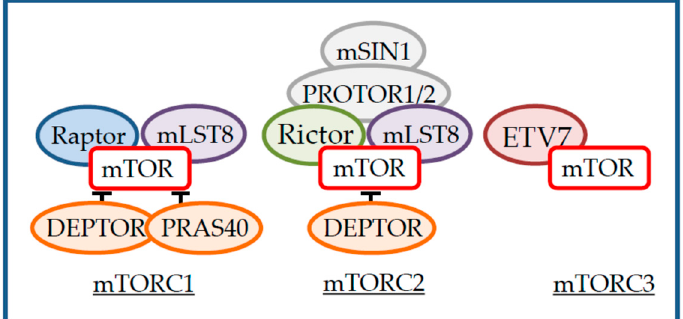
Figure 1. Components of mechanistic target of rapamycin (mTOR) complexes.